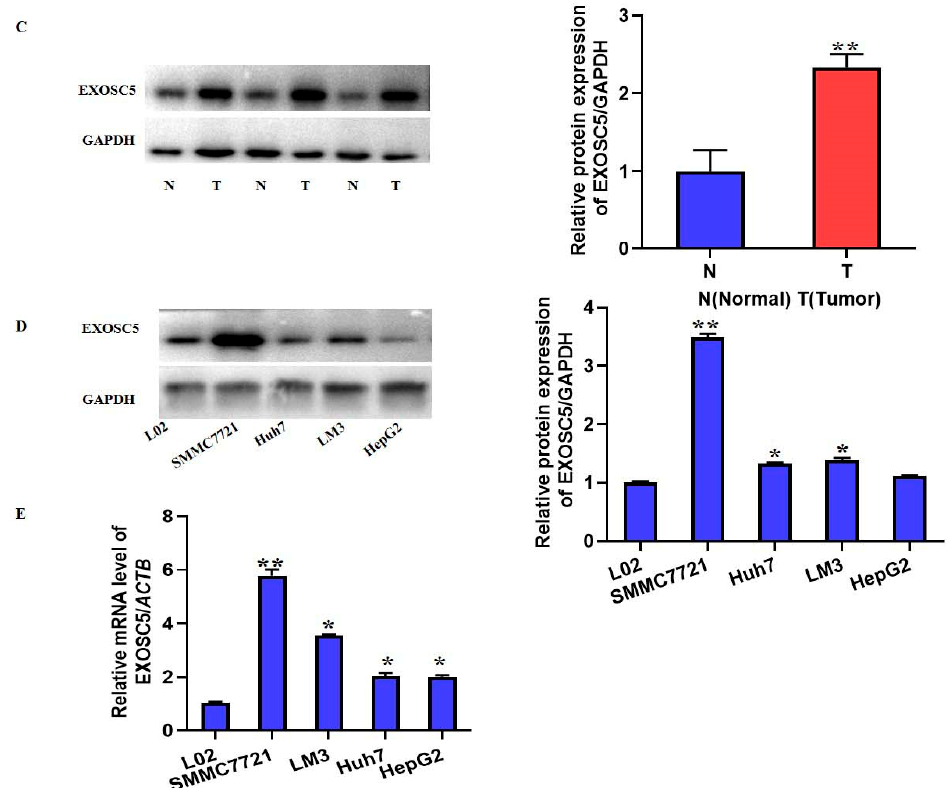
Figure 9. The expression of EXOSC5 in HCC tissue and cell lines. ( A ) The mRNA level of EXOSC5 was detected by qRT-PCR. ( B ) IHC and ( C ) western blot were used to assay the expression of EXOSC5 protein in HCC and adjacent tissues. The protein and mRNA levels of EXOSC5 in L02 hepatocytes and HCC cell lines were detected by ( D ) western blot and ( E ) qRT-PCR. Image J software was used to analyze the relative levels of proteins normalized to the expression of GAPDH. * p < 0.05, ** p < 0.01, compared with its relative control.